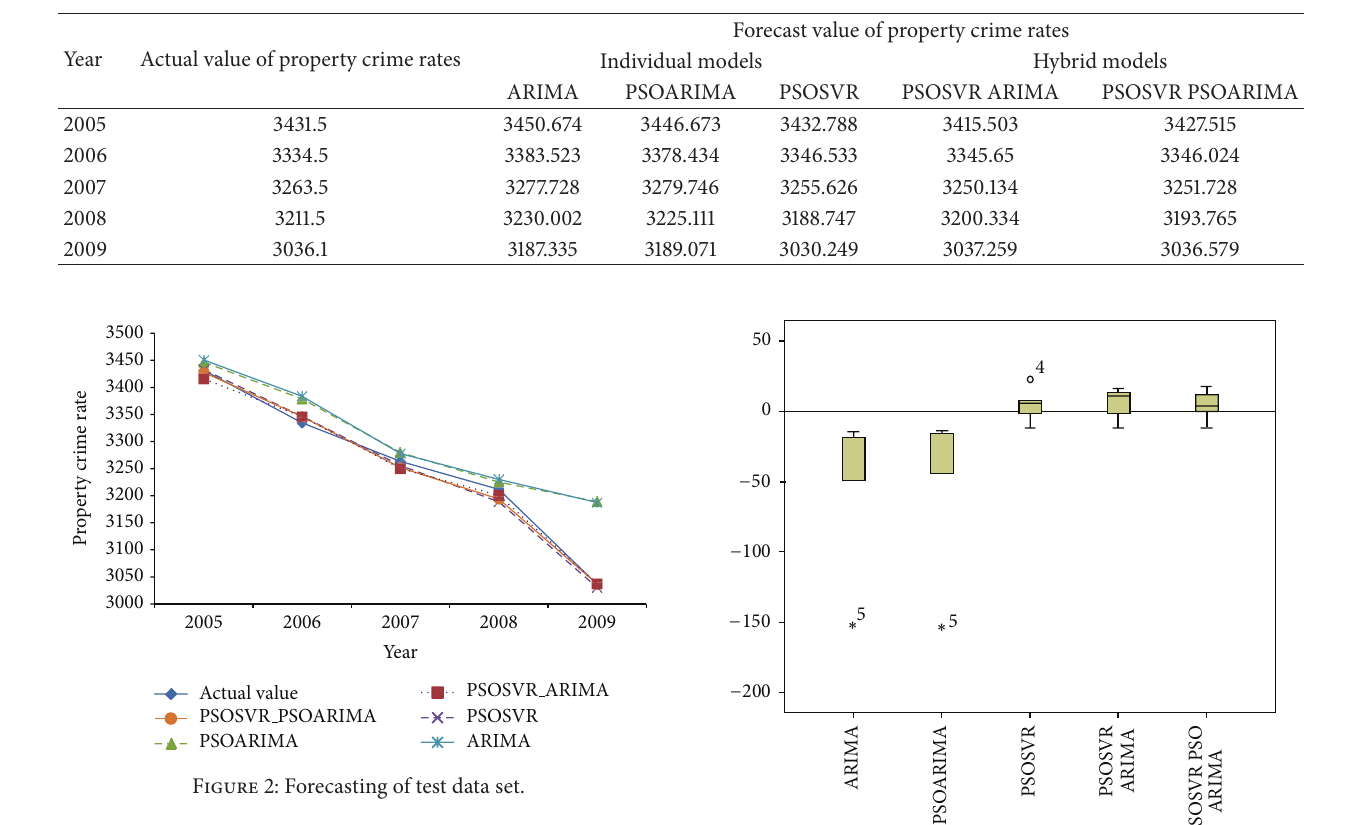
Table 2: Comparison of actual value and forecast value of property crime rates.